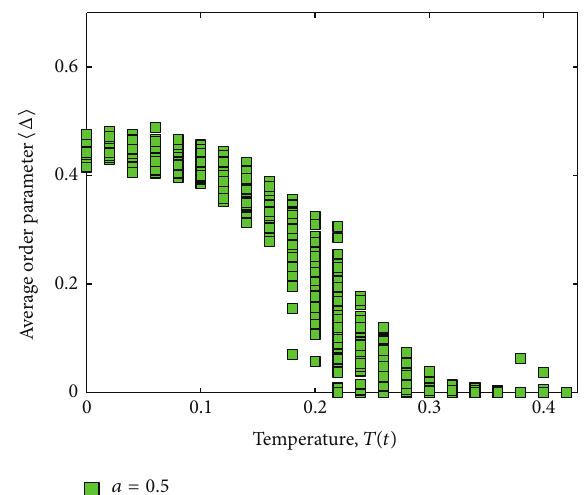
Figure 4: A set of spatially averaged order parameters (in units of 𝑡 ) asafunctionoftemperatureusedforstatisticalaverageoverdifferent configurations at the percolation regime (𝑎 = 0.5) . Note that the distribution has a limited variation